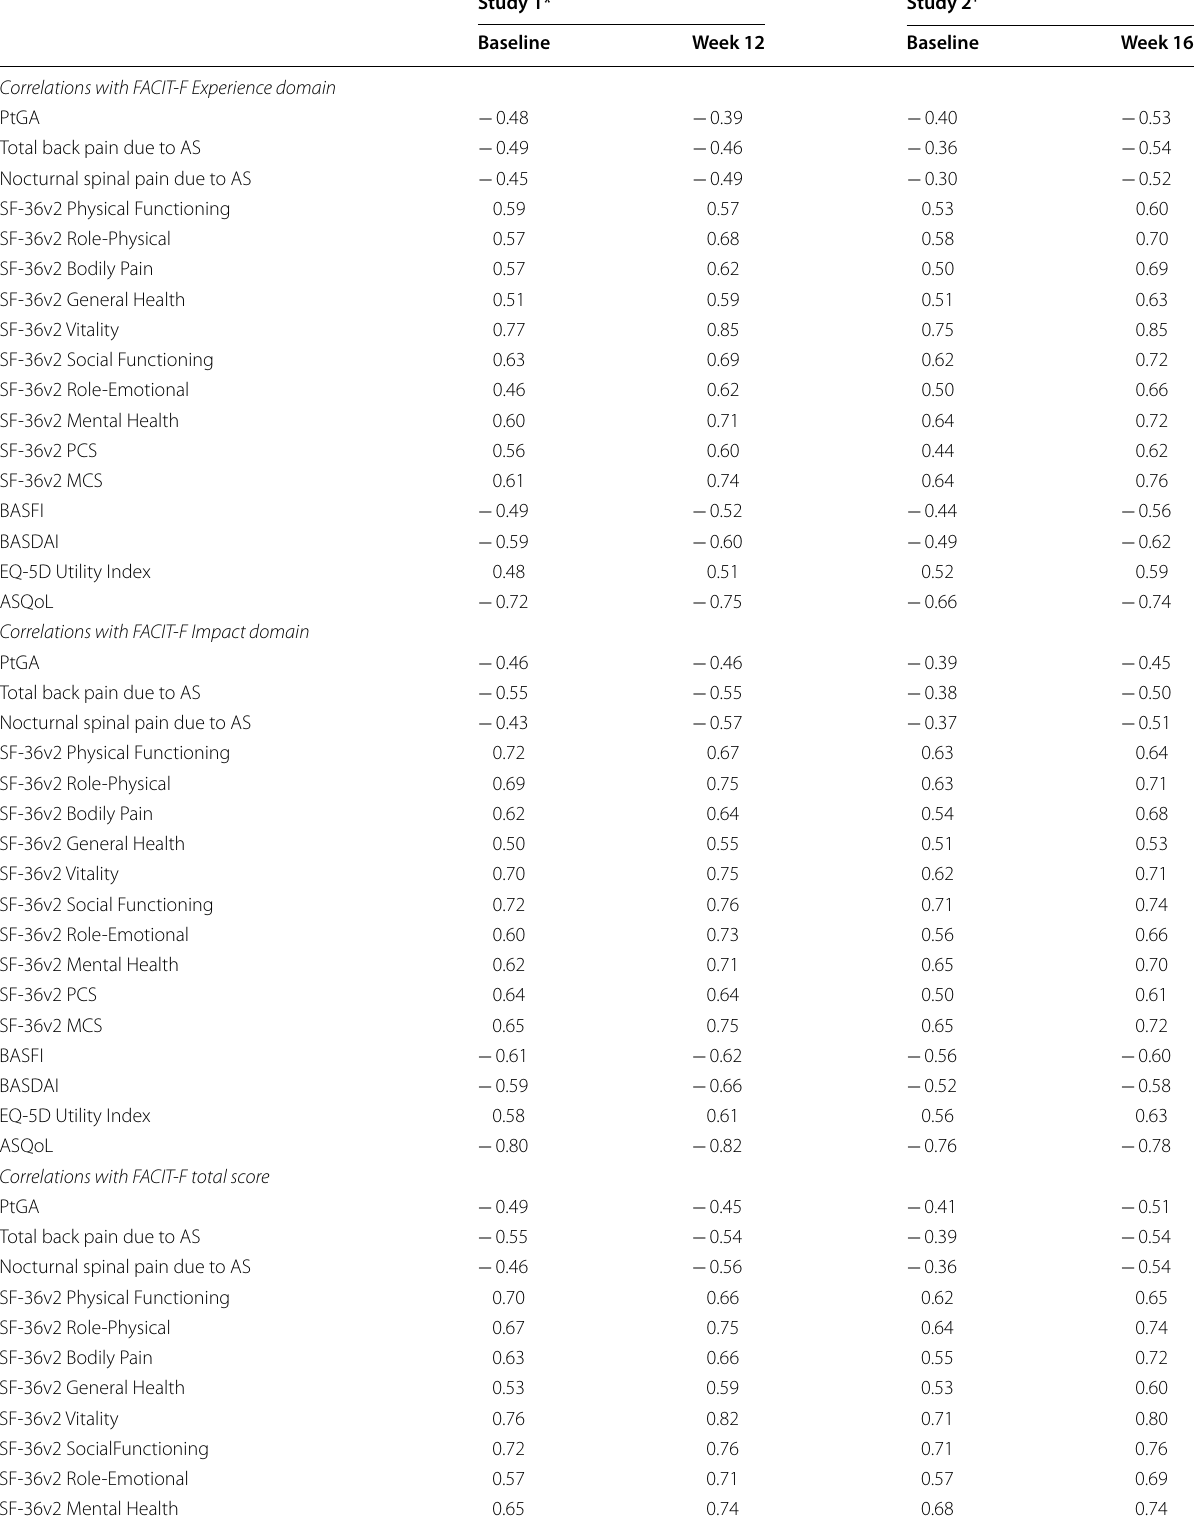
Table 2 Correlations to assess the convergent validity of FACIT‑F versus other PRO measures in patients with active AS Study 1* Study 2 †